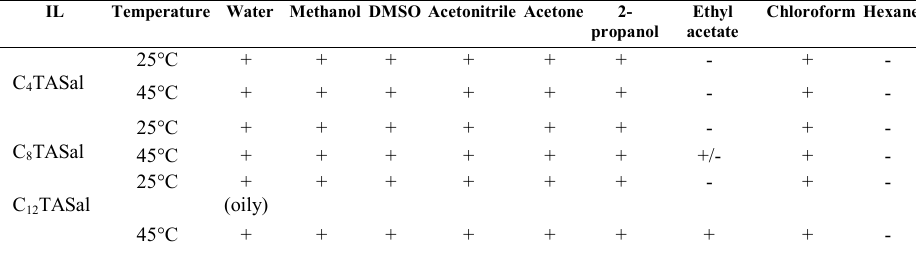
Table 1. Solubilities of the synthesized ILs 1-3 at 25°C and 45°C.